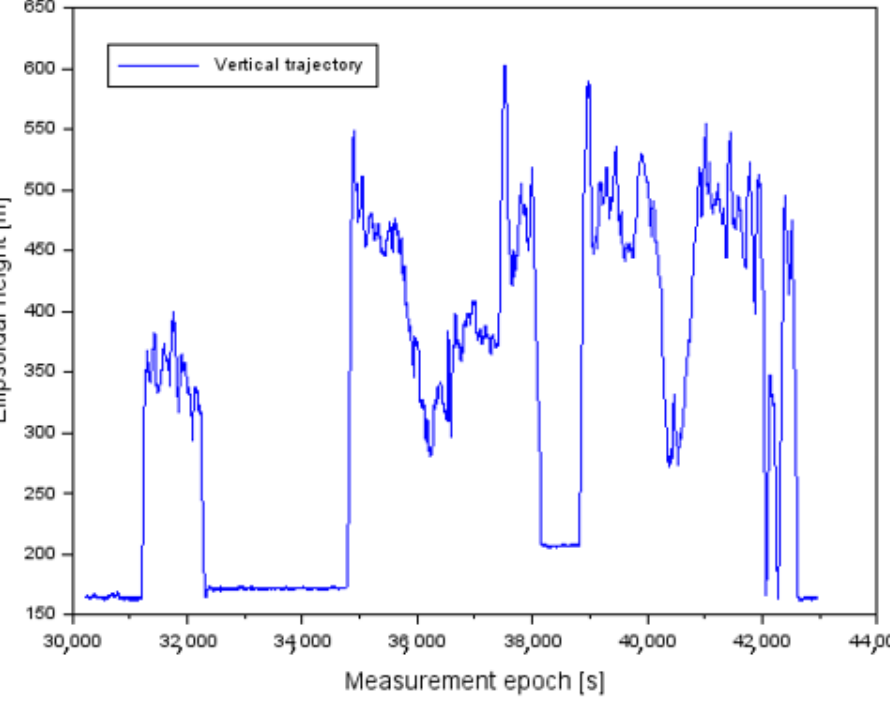
Figure 5. The vertical trajectory of Diamond DA 20-C1 aircraft.